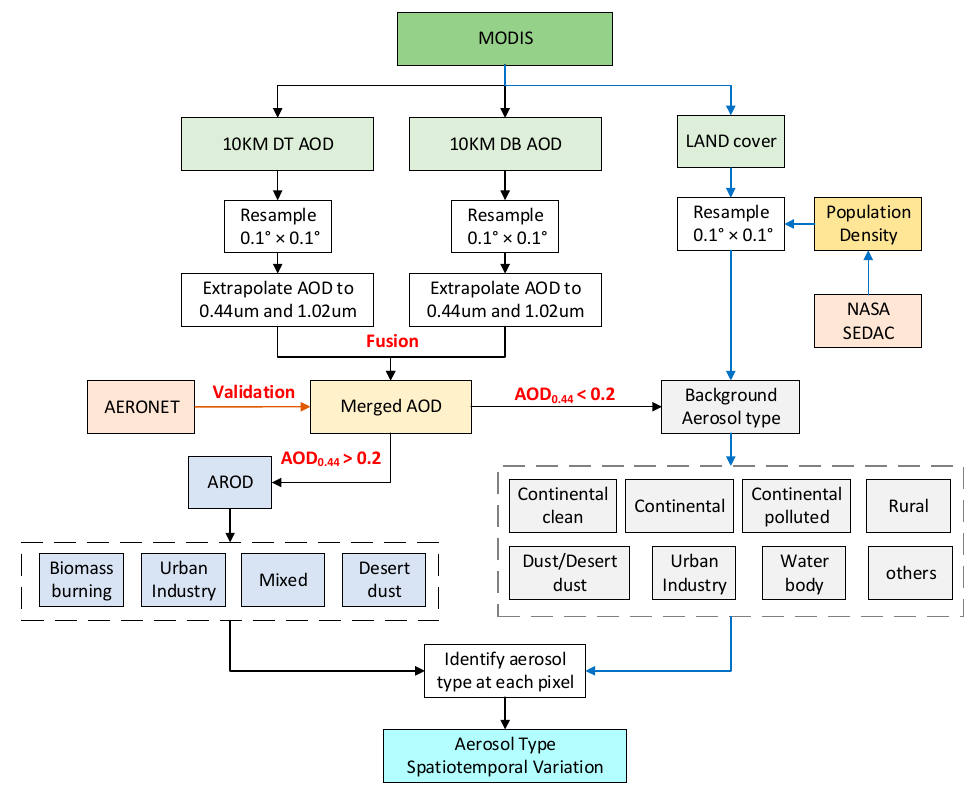
Figure 4. Flowchart of the data processing and aerosol-type classification in this study.